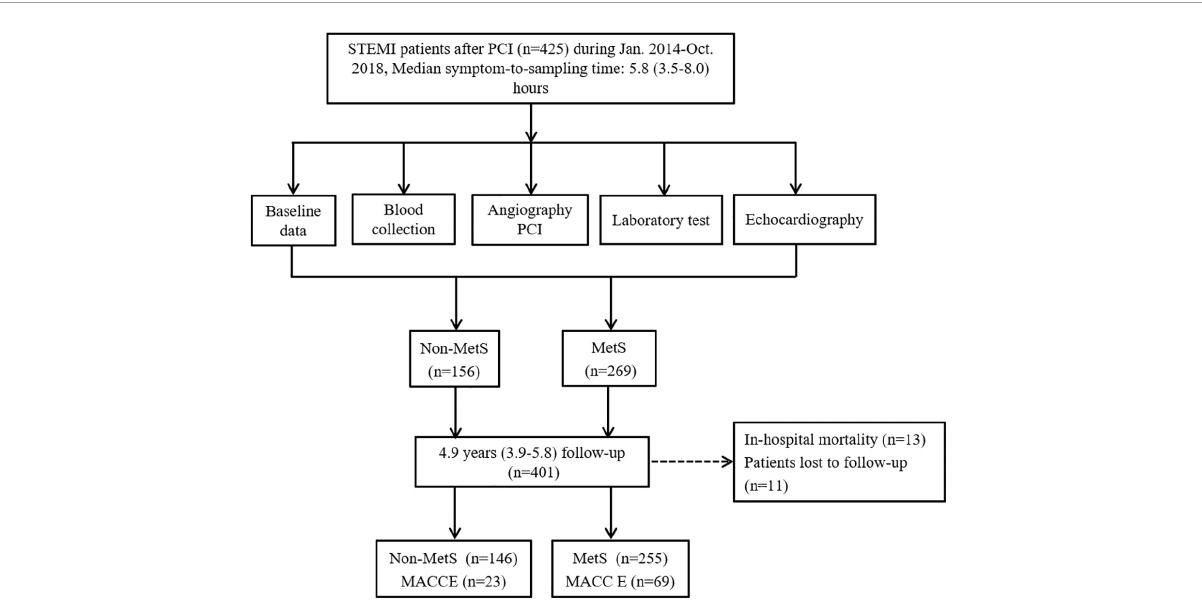
FIGURE1 The flowchart of study design with inclusion and exclusion procedures. MACCE, major adverse cardiovascular and cerebrovascular events; PCI, percutaneous coronary intervention; STEMI, ST-elevation myocardial infarction; MS, metabolic syndrome.